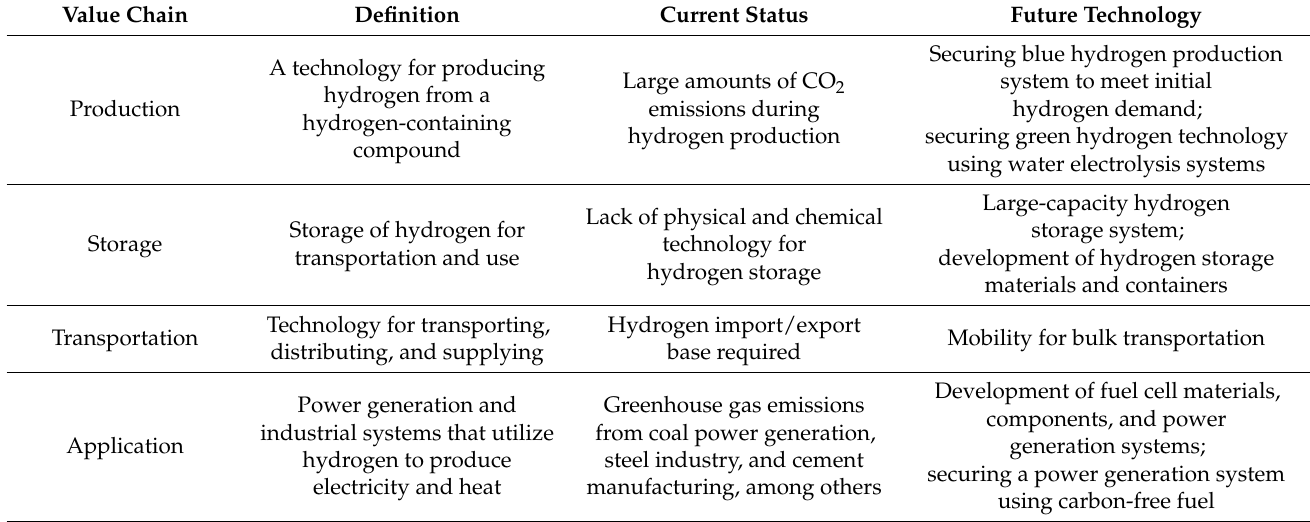
Table 3. Definition and future technologies according to hydrogen value